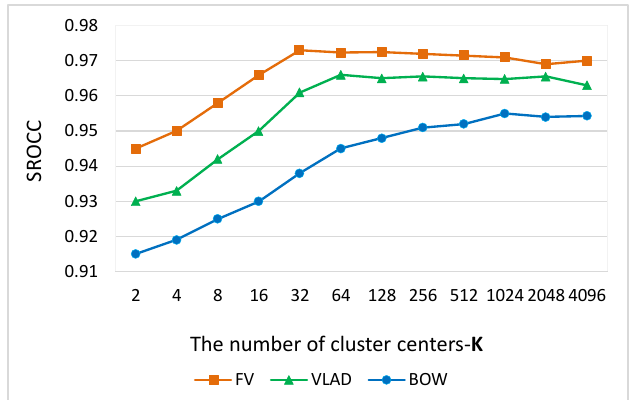
Figure 4. Relationship between the SRCC on LIVE of different feature aggregation layer and the number of K